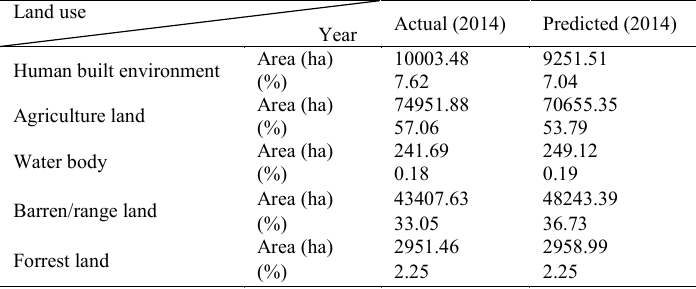
Table 4: Comparison of actual and simualted land use map of 2014